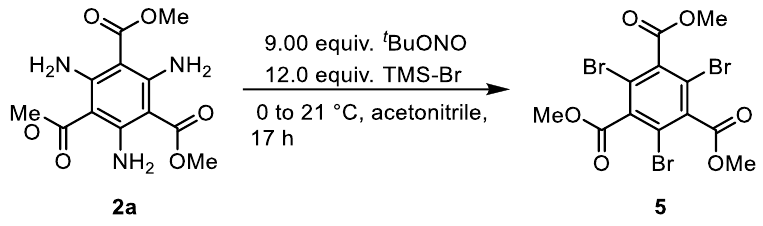
Table 3. Syntheses of tris-1,2,3-triazoles 6